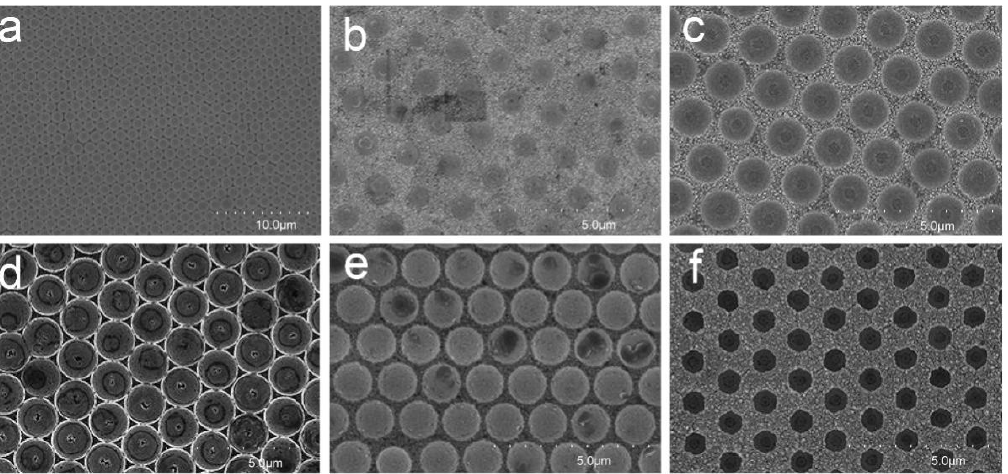
Figure 1. SEM images of ( a ) two-dimensional arrangement PS template with 1.6 µ m diameter, ( b – f ) GCA with different cavity depths (from ( b – f ), 0.3 R, 0.7 R, 1.0 R, 1.2 R, and 1.6 R, respectively) after the template removal.